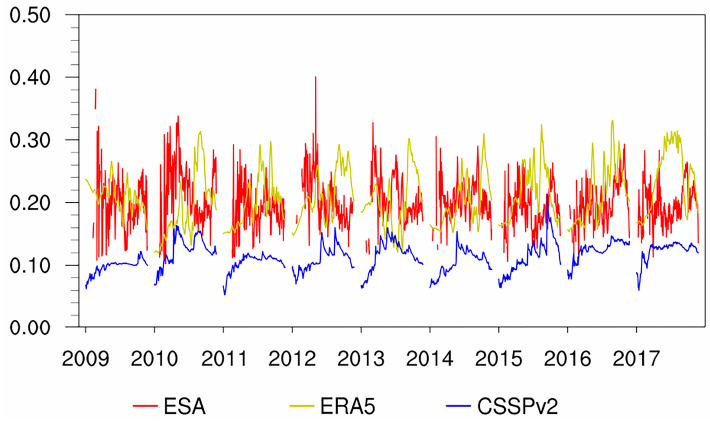
Figure 6. Daily soil moisture averaged over the northwestern part of QTP (masked out in Figure 5) during 2009–2017. during 2009–2017.